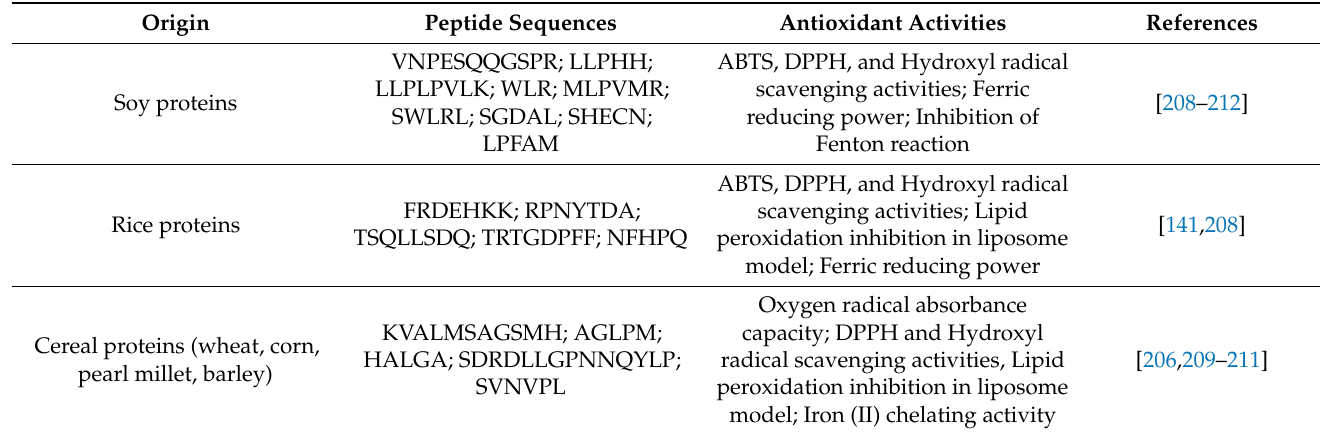
Table 1. Antioxidant peptide sequences from various plant and animal